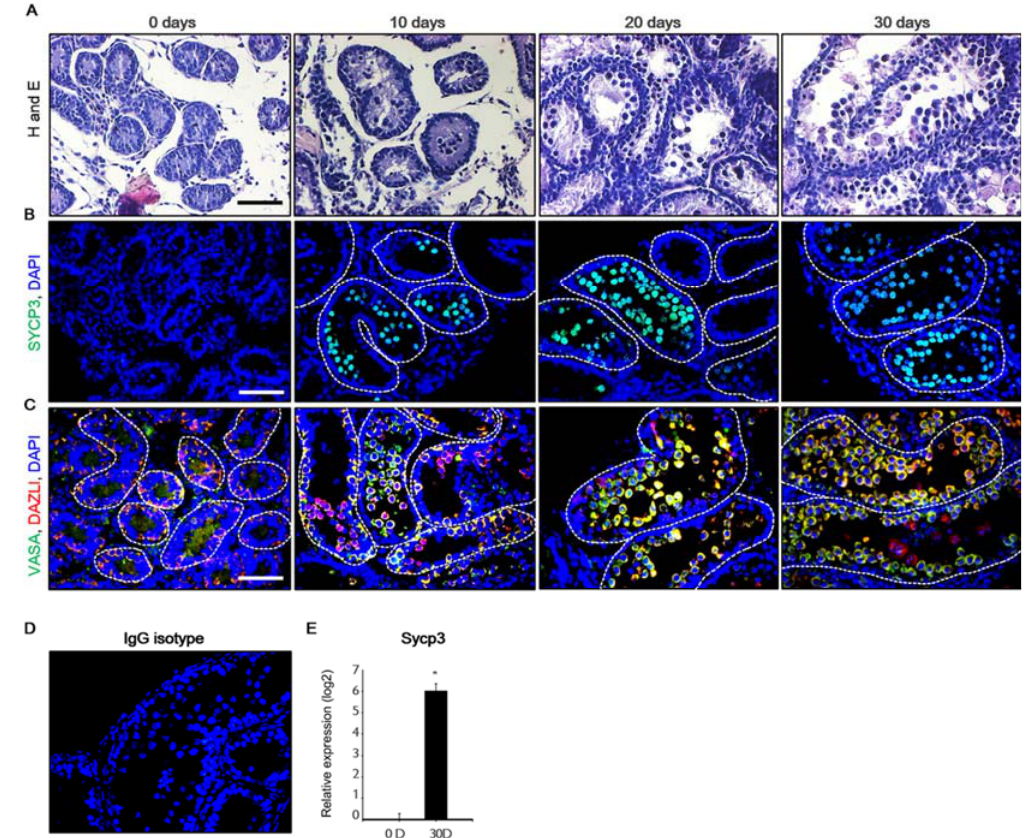
Figure Figure 1. Development of mouse testicular fragments (MTFs) in the in vitro culture model. ( A ) Histological assessments performed using hematoxylin and eosin staining of MTFs cultured for 0, 10, 20, and 30 days. ( B ) SYCP3, ( C ) VASA, and DAZL proteins were detected in the MTFs after 0, 10, 20, and 30 days of culture using